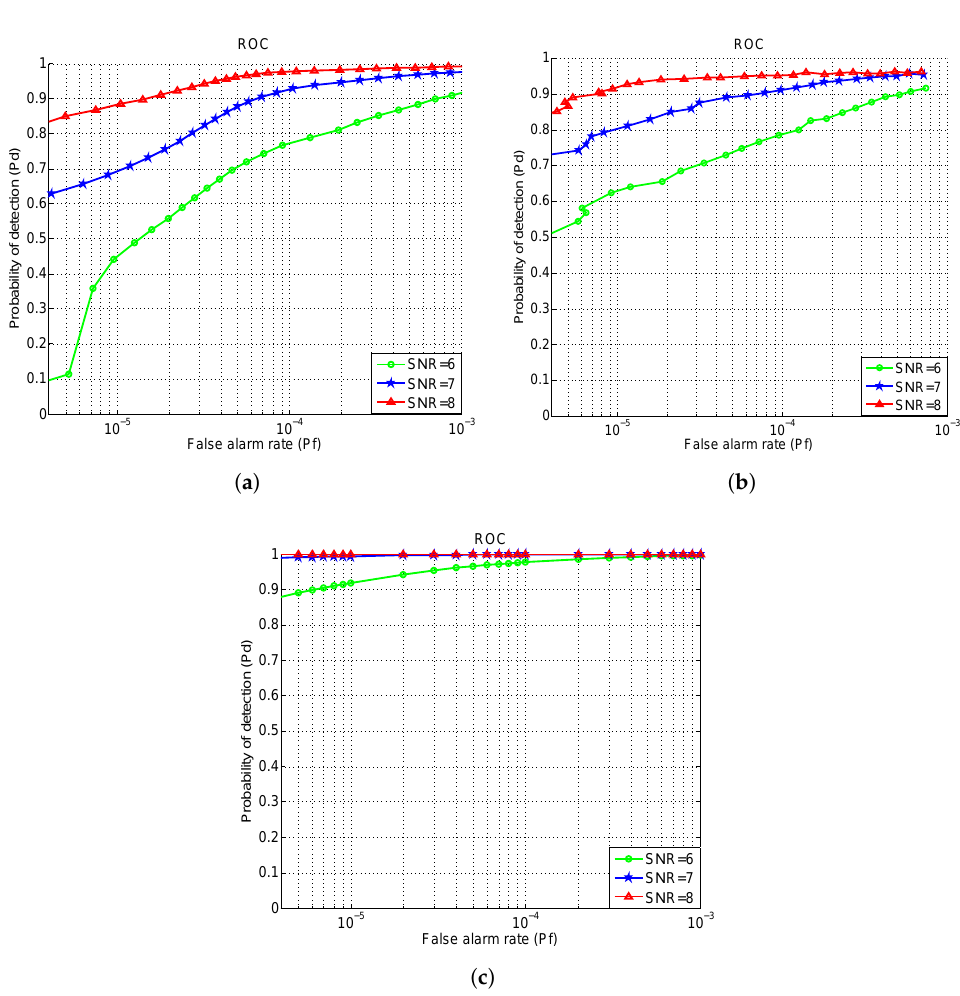
Figure 9. ROC curves achieved by three methods under different SCRs. ( a ) Performance achieved by temporal image differentiation. ( b ) Performance achieved by spatial cloud edge suppression and temporal image differentiation. ( c ) Performance achieved by theoretic